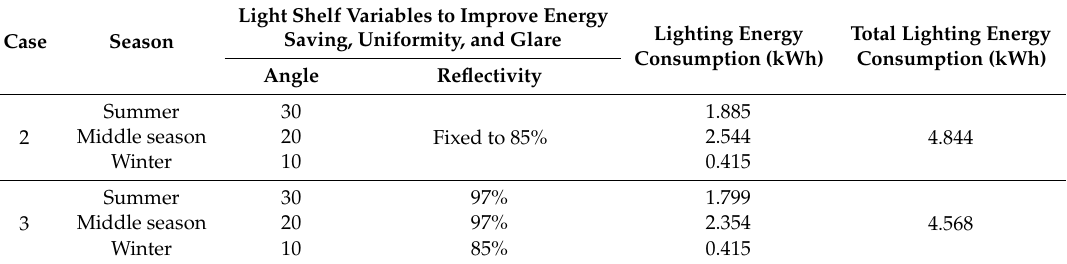
Table 11. Analysis of light shelf variables and lighting energy consumption to improve energy saving and visual